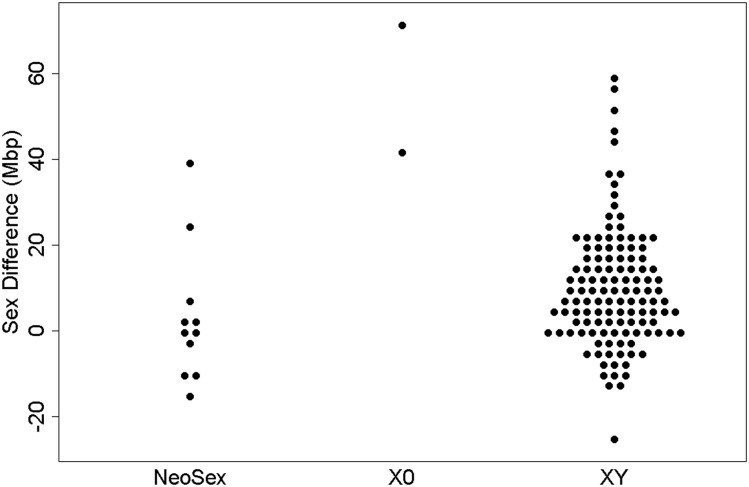
Intersexual difference between documented Neo-Sex, XO, and XY species.